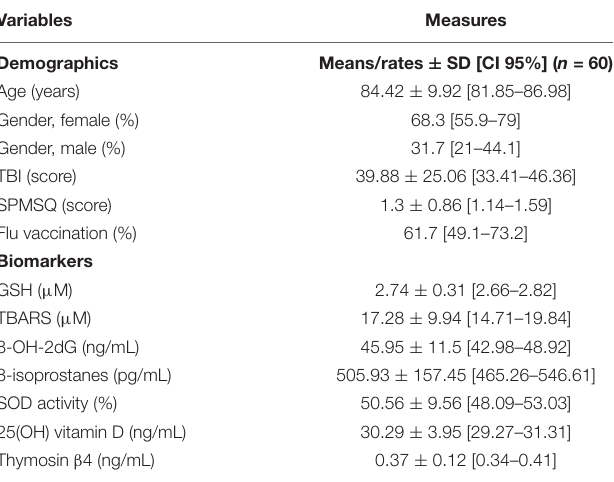
TABLE 1 | Baseline descriptive analysis (January